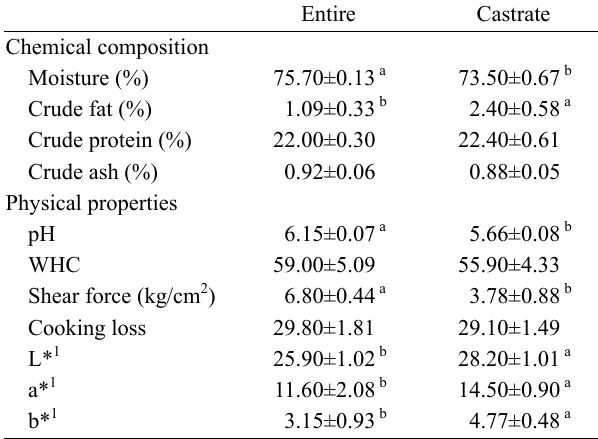
Table 2. Physicochemical characteristics of entire and castrate